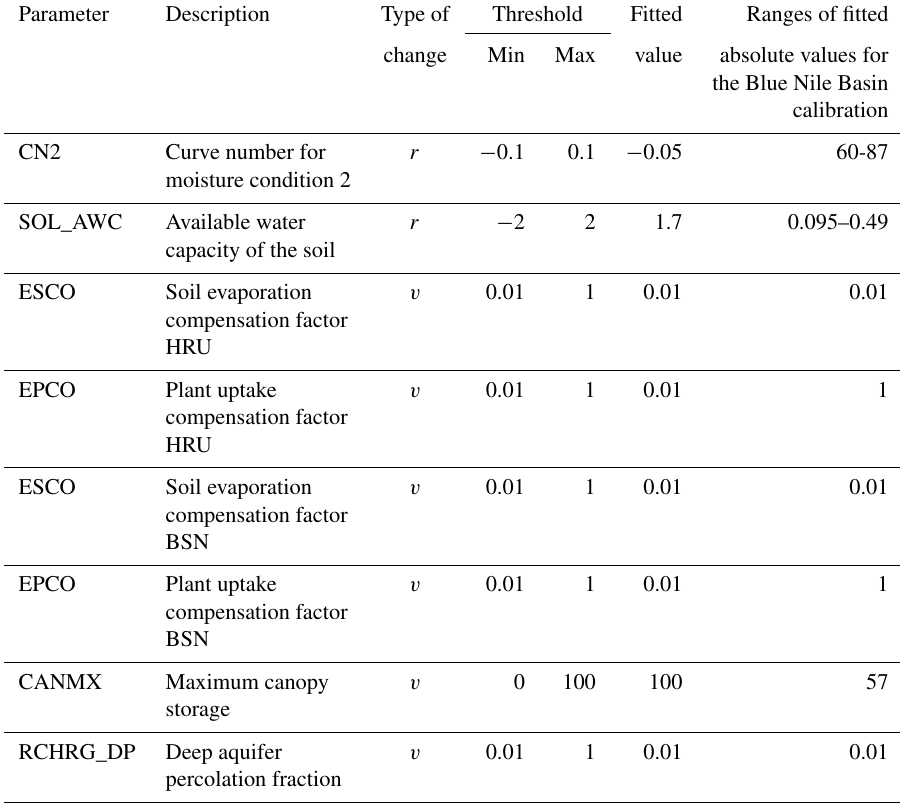
Table 2. Parameterization of the SWAT models using the SUFI-2 algorithm for the period 1990–2004. BSN means applied to the entire basin.